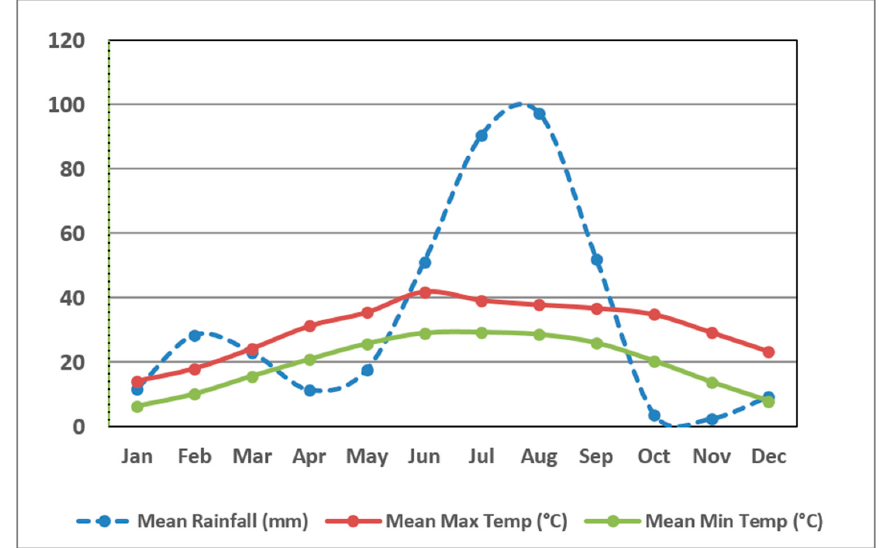
Figure 1. Time series graph of temperature and precipitation.